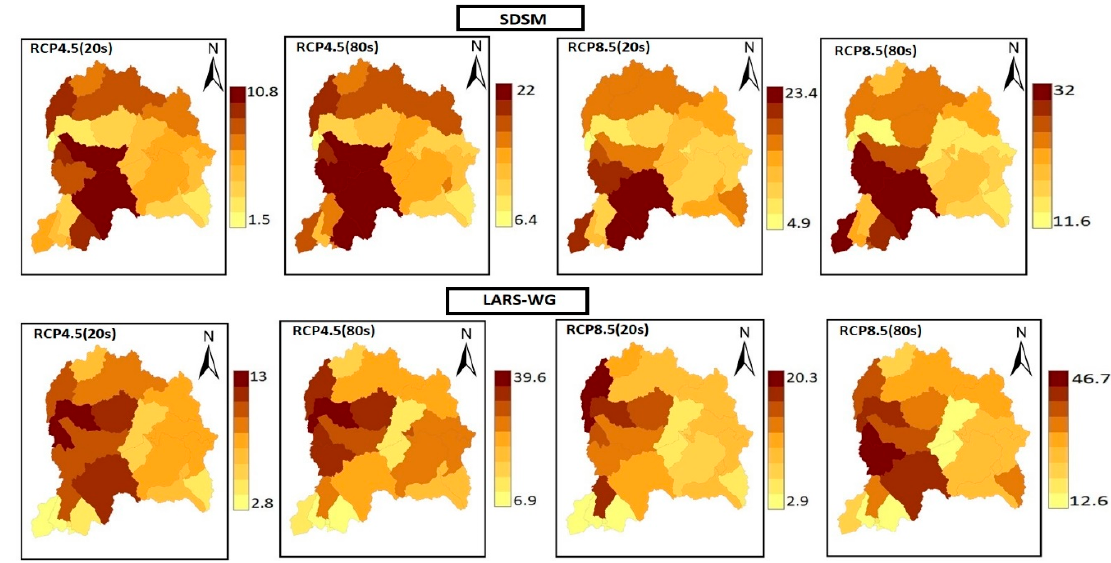
Figure 11. Spatial distribution of relative change rate (%) in water yield in the Jhelum River Basin with SDSM and LARS-WG under RCP4.5 and RCP8.5.